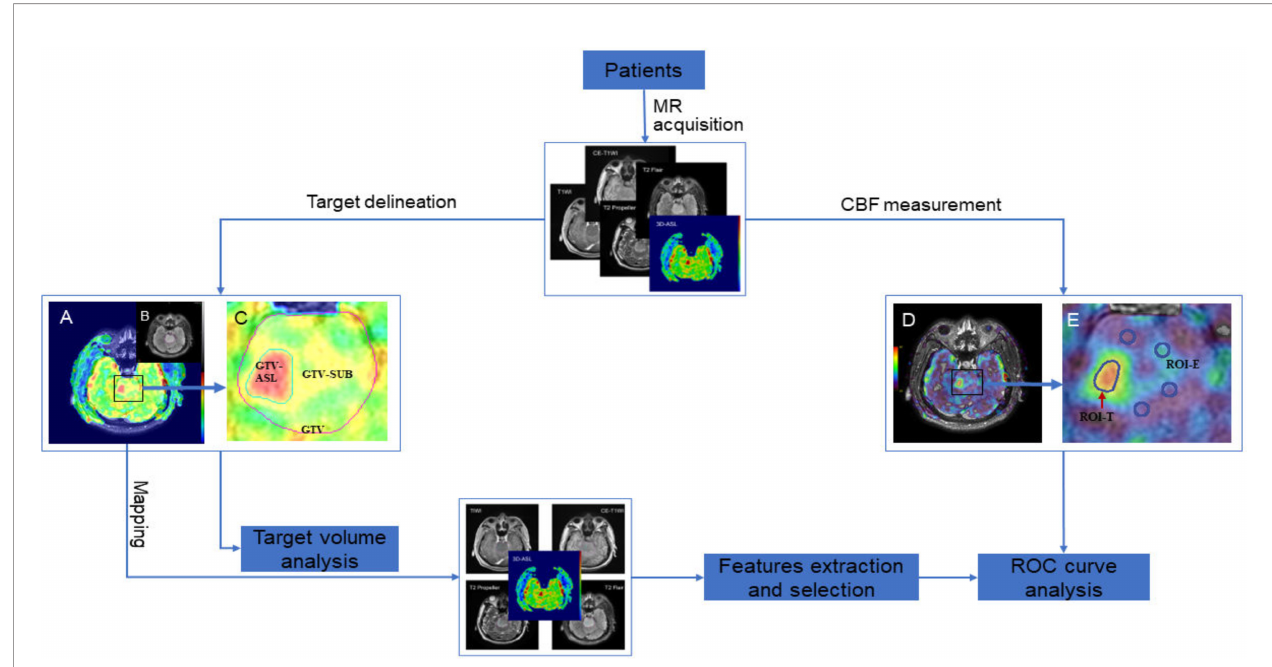
FIGURE 1 | Flow chart of this study. (A, D) , fusion images of T2 Flair and 3D-ASL; (B) T2 Flair image; (C, E) , local magni fi cation of (A, D) ,